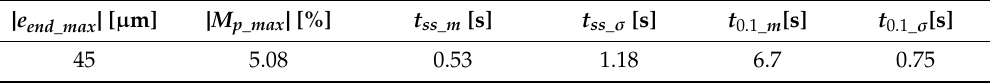
Figure 10. SFC+I M controller positioning test results: ( a ) position vs. reference; ( b ) error evolution in time; ( c ) detail of (b), showing the step where M p_max occurred. Table 4. SFC+I controller with new integral law performance metrics.